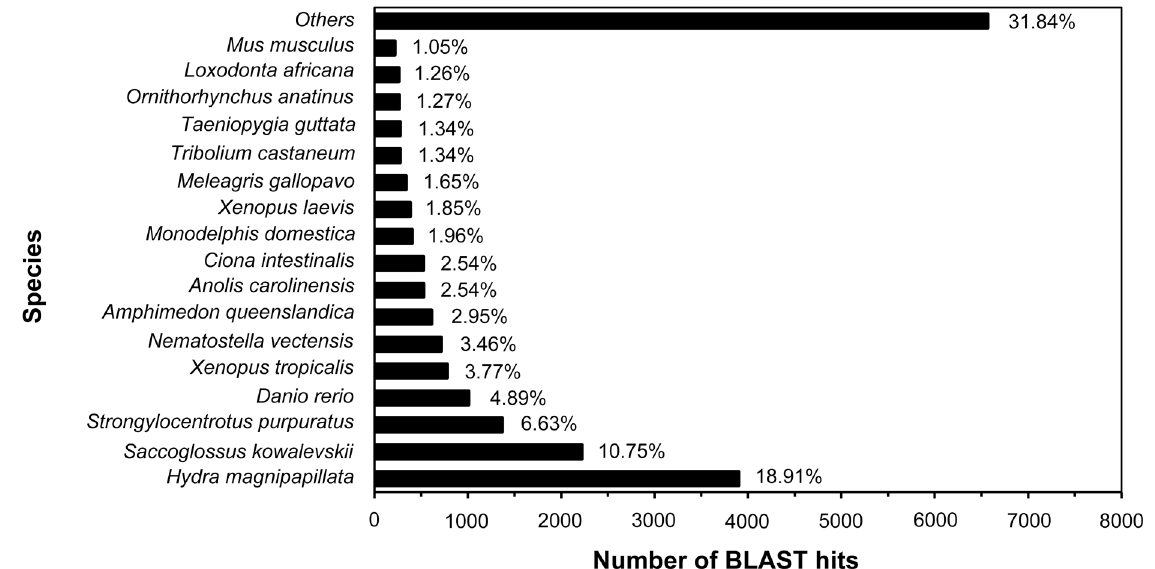
Fig 1. Top-hit species distribution of the BLASTx matches of the unigenes. The species distributions of the top BLASTx hits against the Nr database were analyzed (cut-off e-value < 10 − 5 ). Species with proportions of greater than 1% are shown.